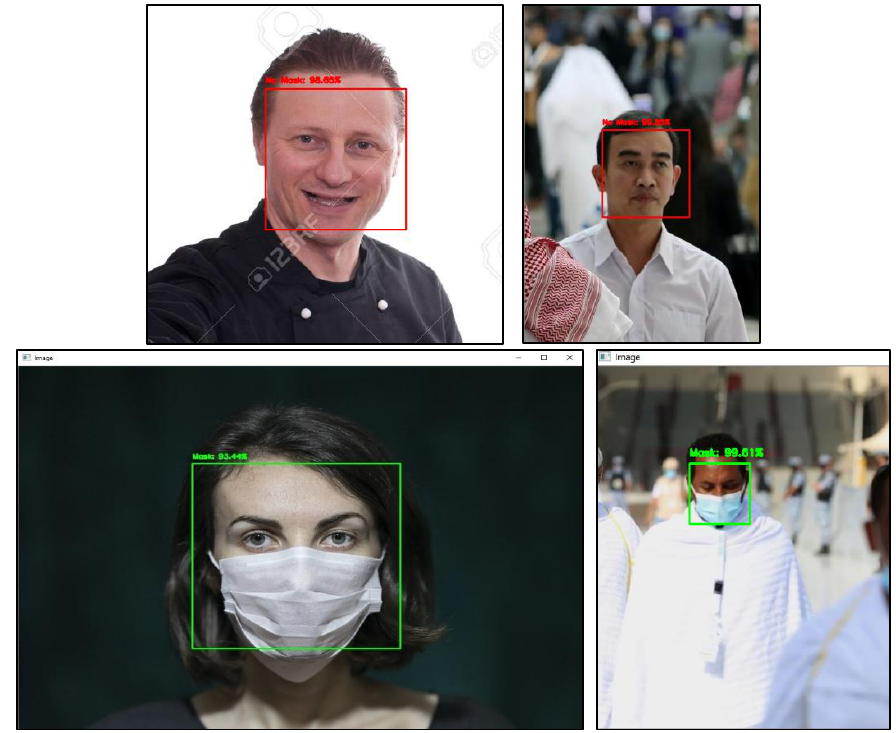
Figure 5. Result of the proposed model for mask detection.